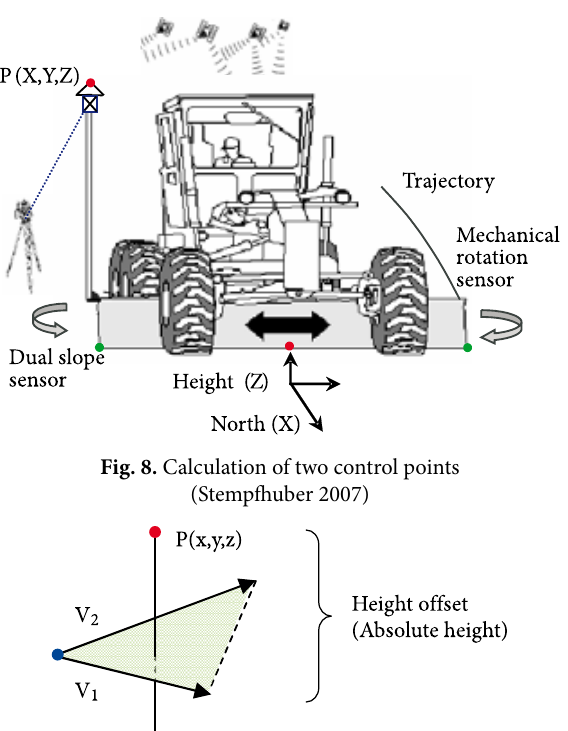
Fig. 9. Calculation – absolute height with a triangle